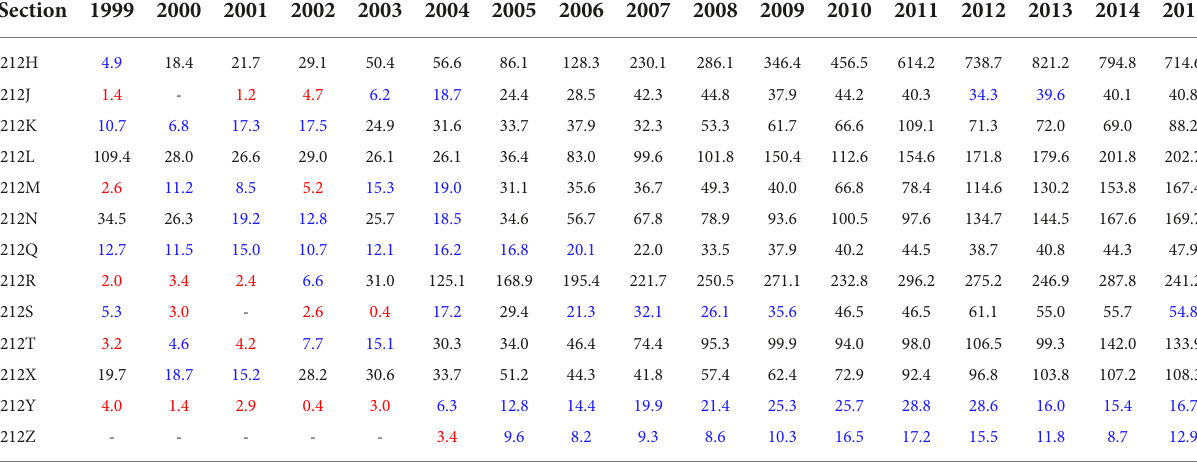
TABLE 7 Annual disturbance (1000 hectares) by section